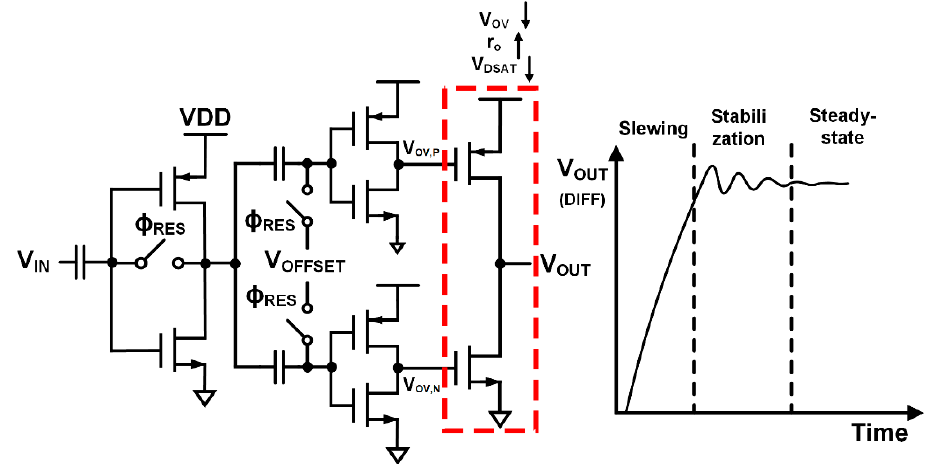
Figure 5. The conventional ring amplifier structure with three inverters (single-ended view) and its transient response (differential mode). transient response (differential